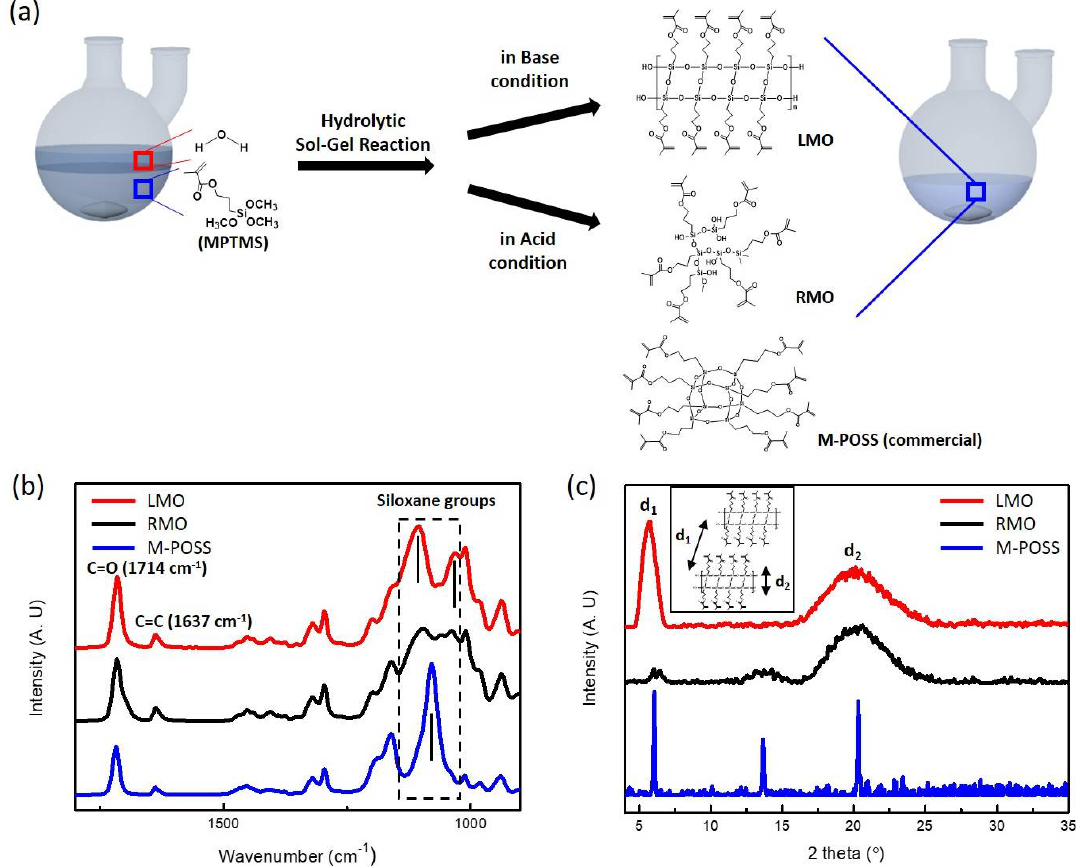
Figure 1. Molecular structures of the synthesized LMO, RMO, M-POSS resin. ( a ) Synthesis scheme of the methacrylate oligo-siloxanes via sol–gel hydrolysis and condensation; ( b ) FT-IR spectra of the MOs in the range of 900~1800 cm −1 (siloxane groups in the range of 1000~1150 cm −1 ); ( c ) thin film X-ray diffraction patterns of the methacrylate oligo-siloxane resins.